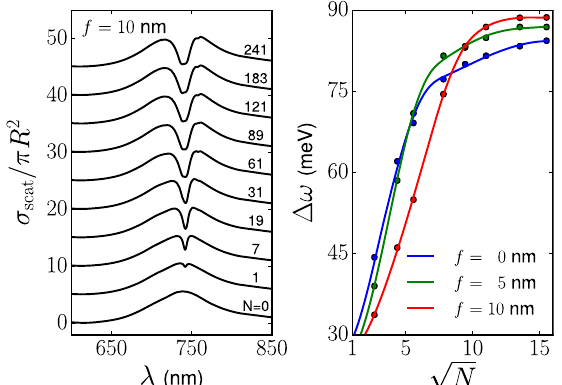
Fig. 3. (a) Scattering cross-sections s scat of the NPoM with f =10 nm accommodating N quantum emitters as indicated. Each line is offset by 5 p R 2 . (b) Spectral splitting D v = v + (cid:2) v (cid:2) of the hybrid states between N emitters and BDPs of the NPoM with f =0, 5 and 10 nm. The N emitters are organized in a hexagonal lattice with lattice spacing